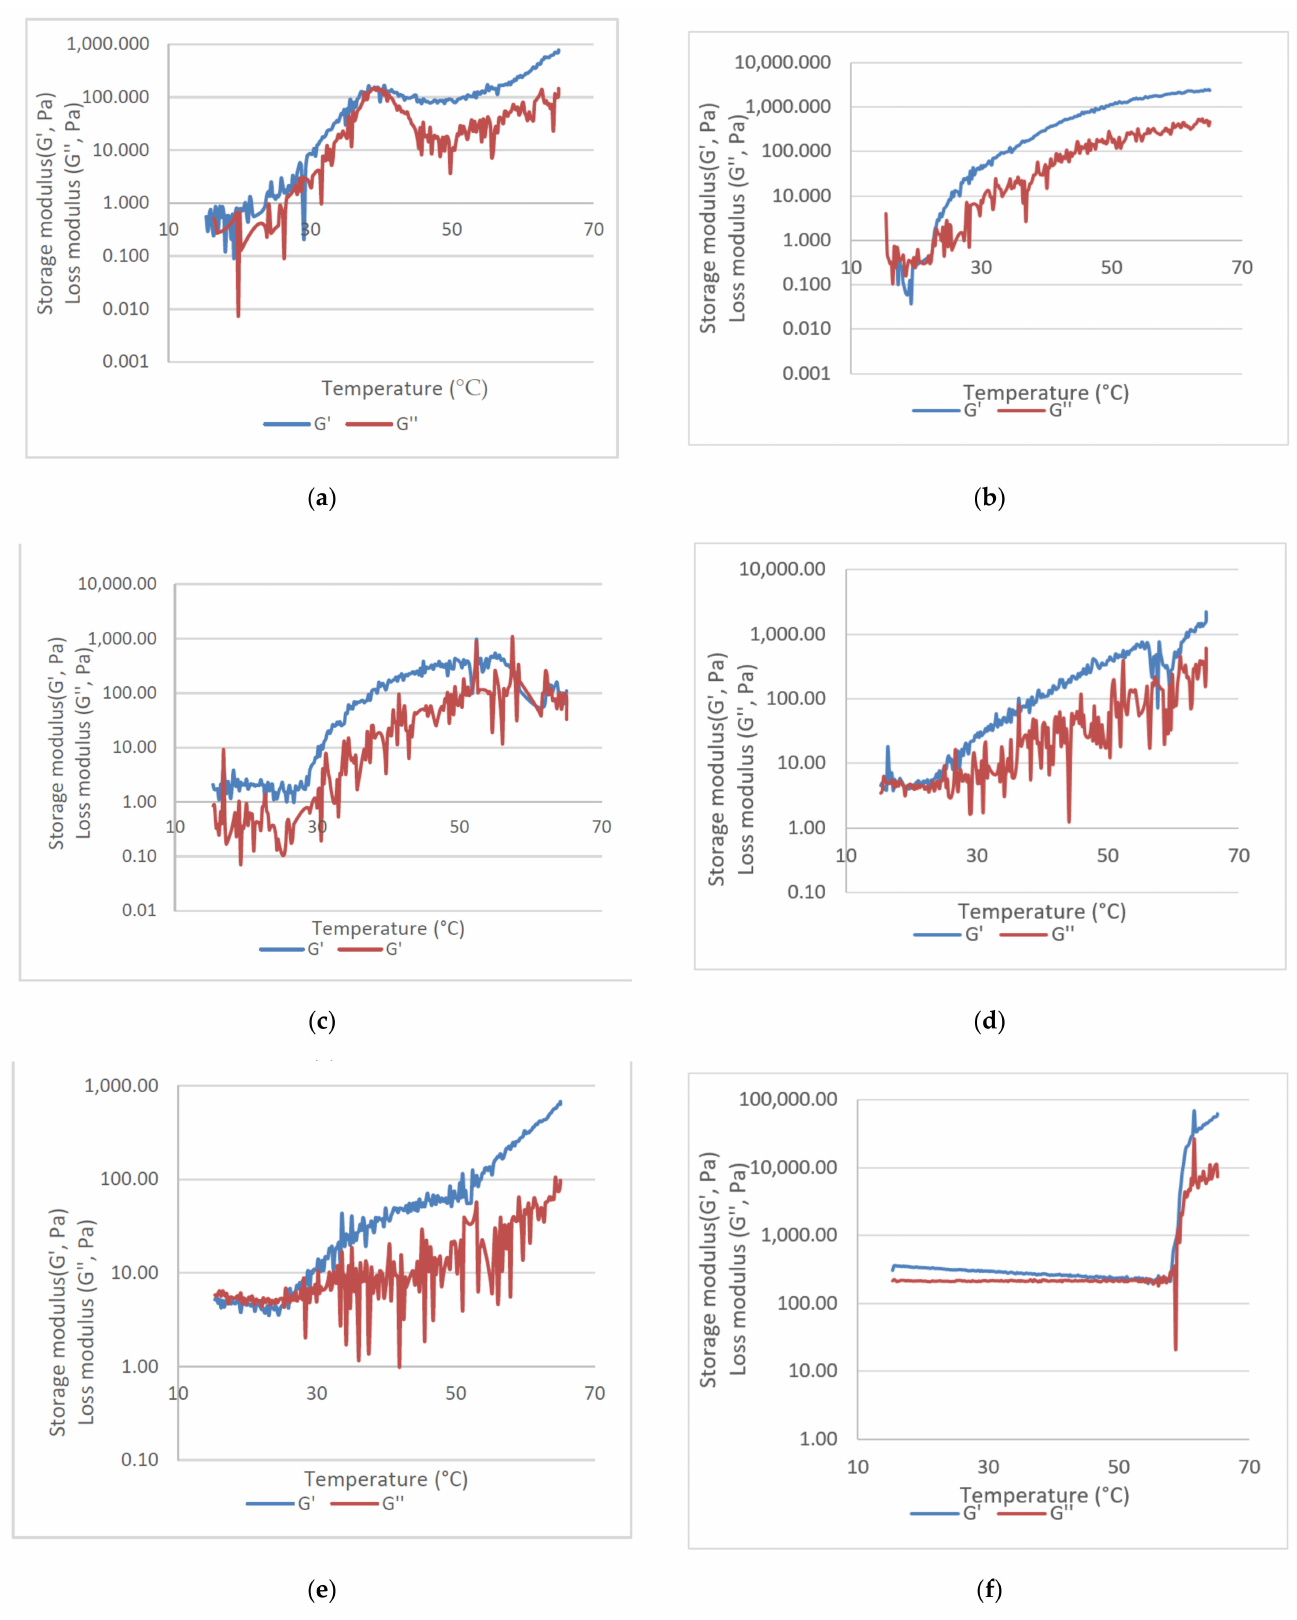
Figure 4. Storage (G (cid:48) ) and loss (G (cid:48)(cid:48) ) moduli for ( a ) PluW, ( b ) PluWE, ( c ) PluWE-Epi, ( d ) Epi-Gel, ( e ) CurEpi β CD-gel and ( f ) sodium